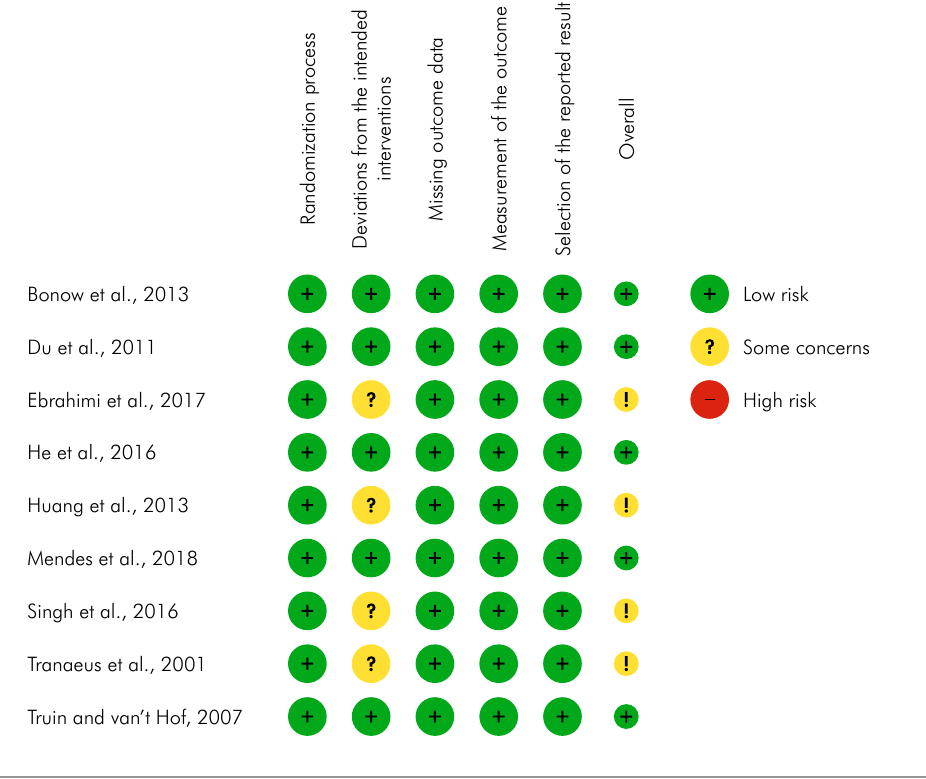
Figure 2. Risk of bias assessment using the recommended Cochrane tool for RCTs (RoB